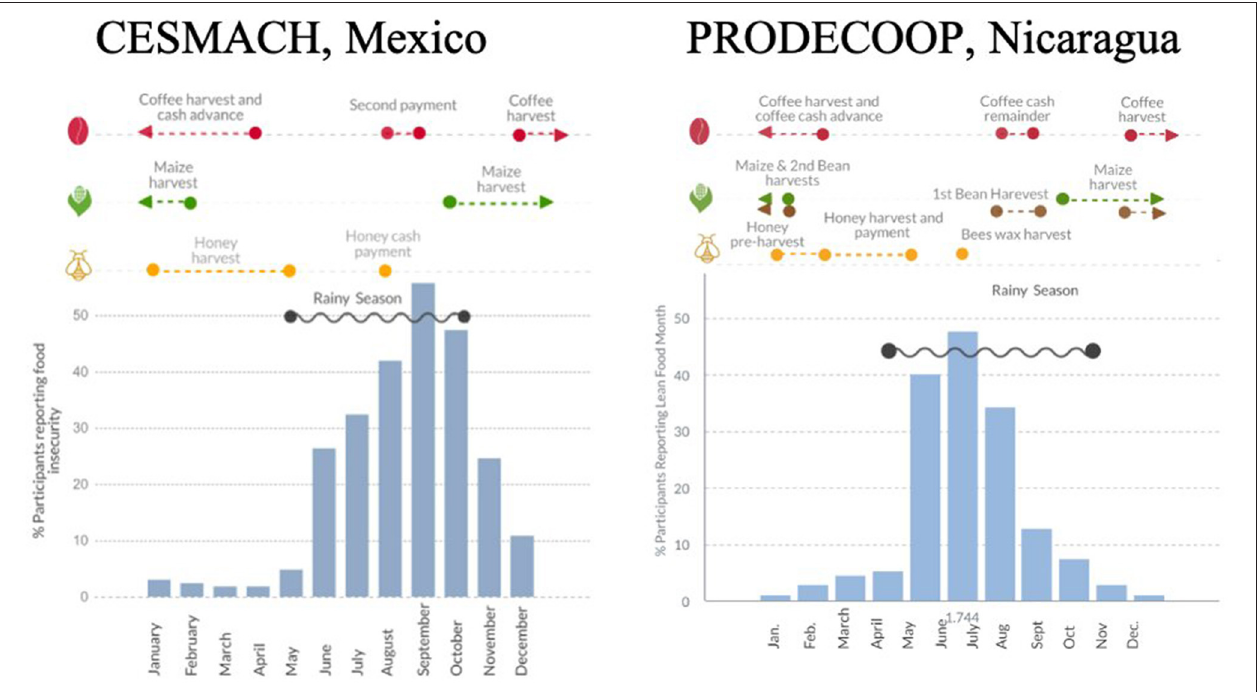
FIGURE 2 | Key moments in the agriculture and cooperatives cycles, as well as lean months. Left graph was published in Anderzén et al., 2020, p. 42. Right graph data came from 171 Household Surveys Northern Nicaragua, 2017 and Focus Groups (Bacon et al.,